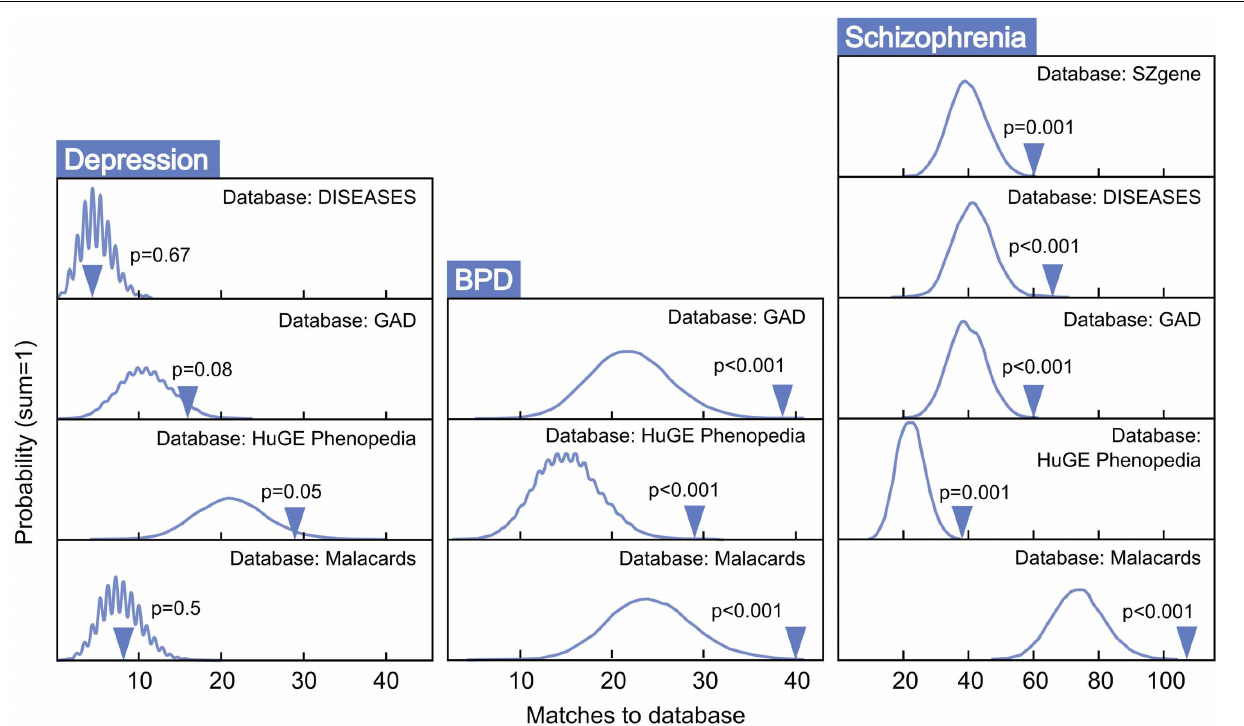
FIGURE 4 | MSET evaluation of enrichment for depression, BPD, and schizophrenia-associated gene sets within significantly altered genes in maternal mPFC. Y-axis represents the probability of X matches to database appearing in a randomly generated set of simulated results from the microarray background. The blue arrow shows how many